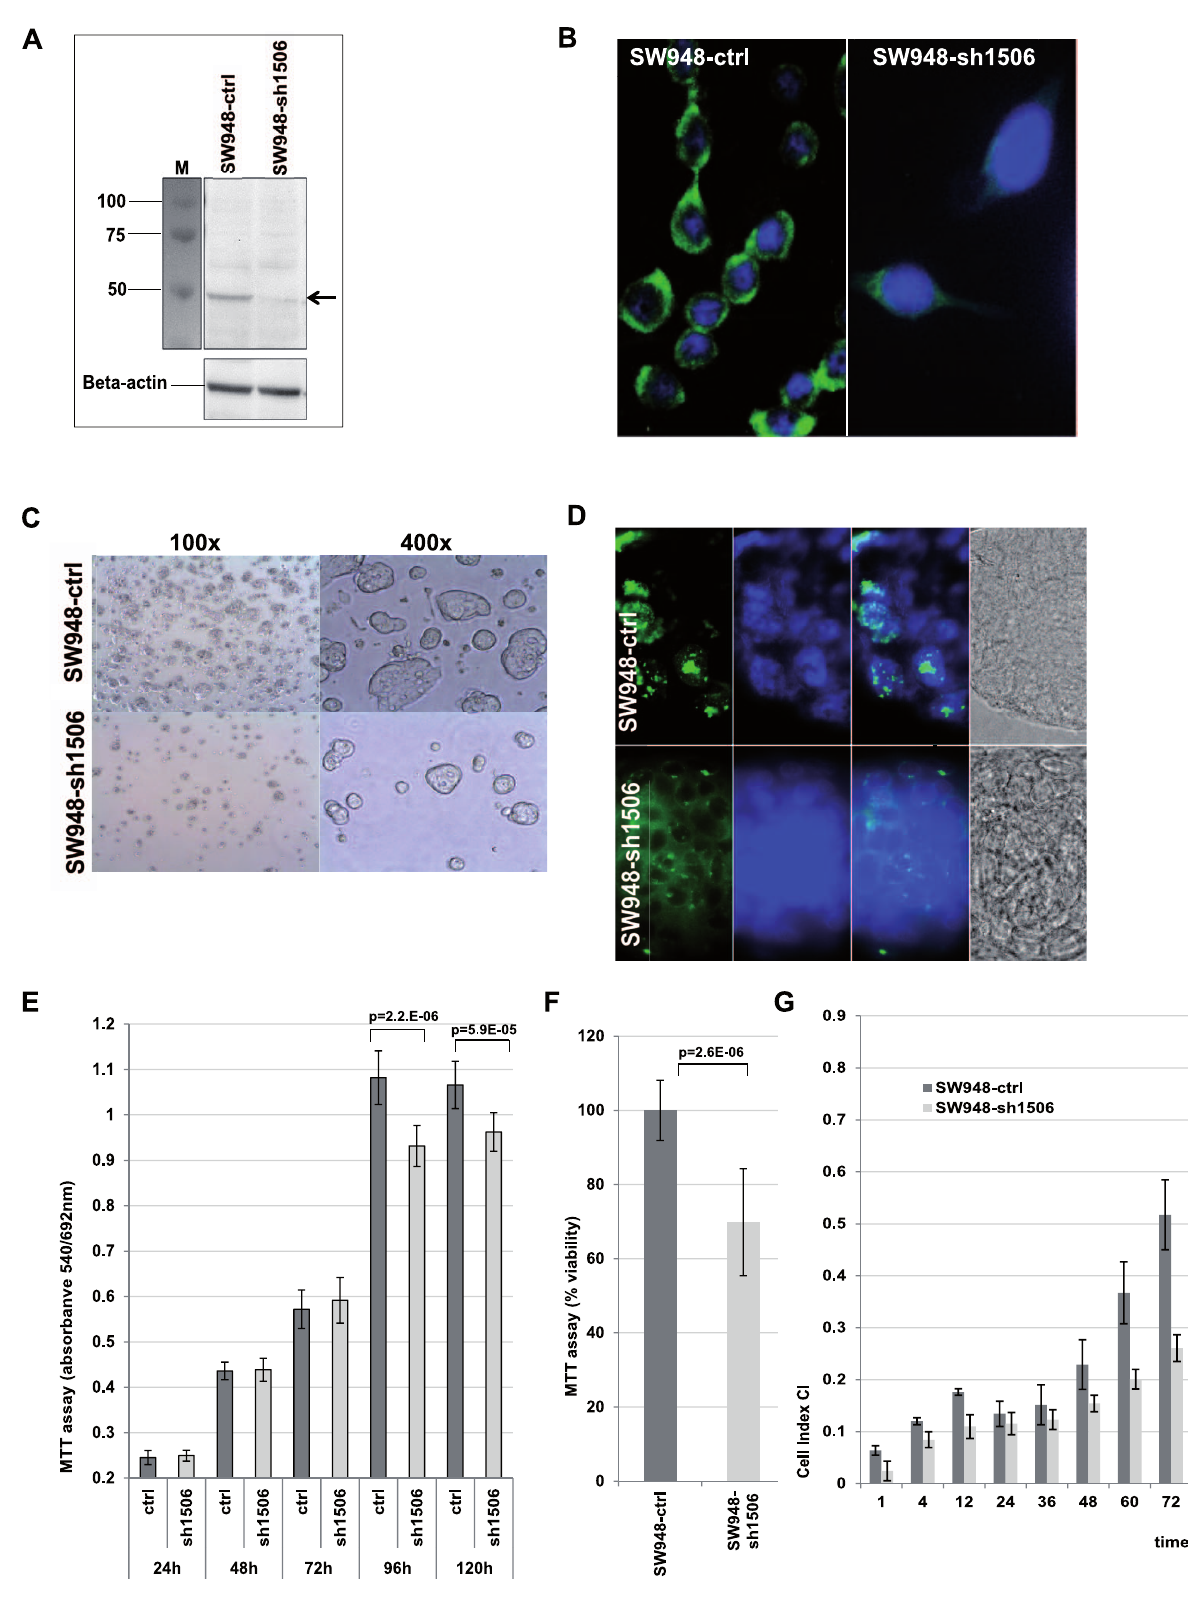
Figure 3. Knockdown of KRT23. A ) Western Blot of freshly made SW948-ctrl and SW948-sh1506 cells extracts with 20 m g extract per lane using a monospecific anti-K23 antibody in a 1:150 dilution, Marker Biorad All Blue. Stable knockdown of K23 in the SW948-sh1506 cells resulted in . 80% reduced K23 protein expression compared to the SW948-ctrl cells. Beta-actin was used as loading control. B) Immunofluorescence analysis confirmed a decreased K23 expression in SW948-sh1506 cells; anti-K23 antibody 1:500, detection with Alexa 488, nuclear stain Hoechst, magnification 630x C)